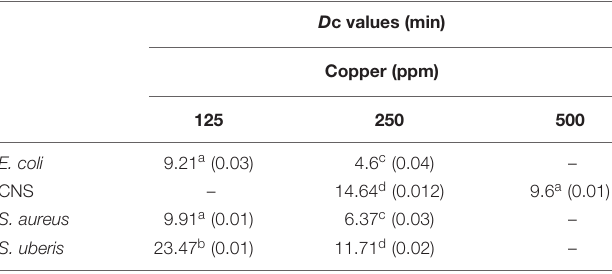
TABLE 2 | Dc values (min) for strains isolated from clinical bovine mastitis exposed to different copper